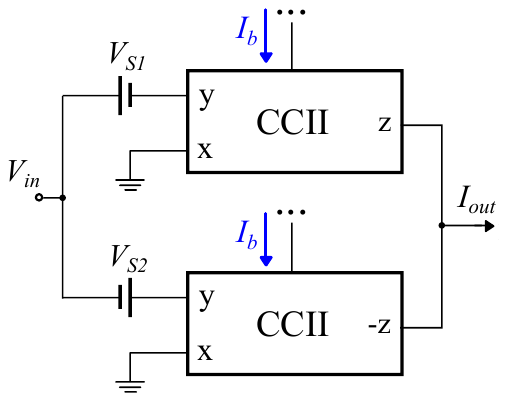
Figure 32. A current conveyor second generation based Gaussian function circuit. Table 5. Gaussian Function Circuits using extra components. * Does not include the extra components. ** For the entire system. Ref.